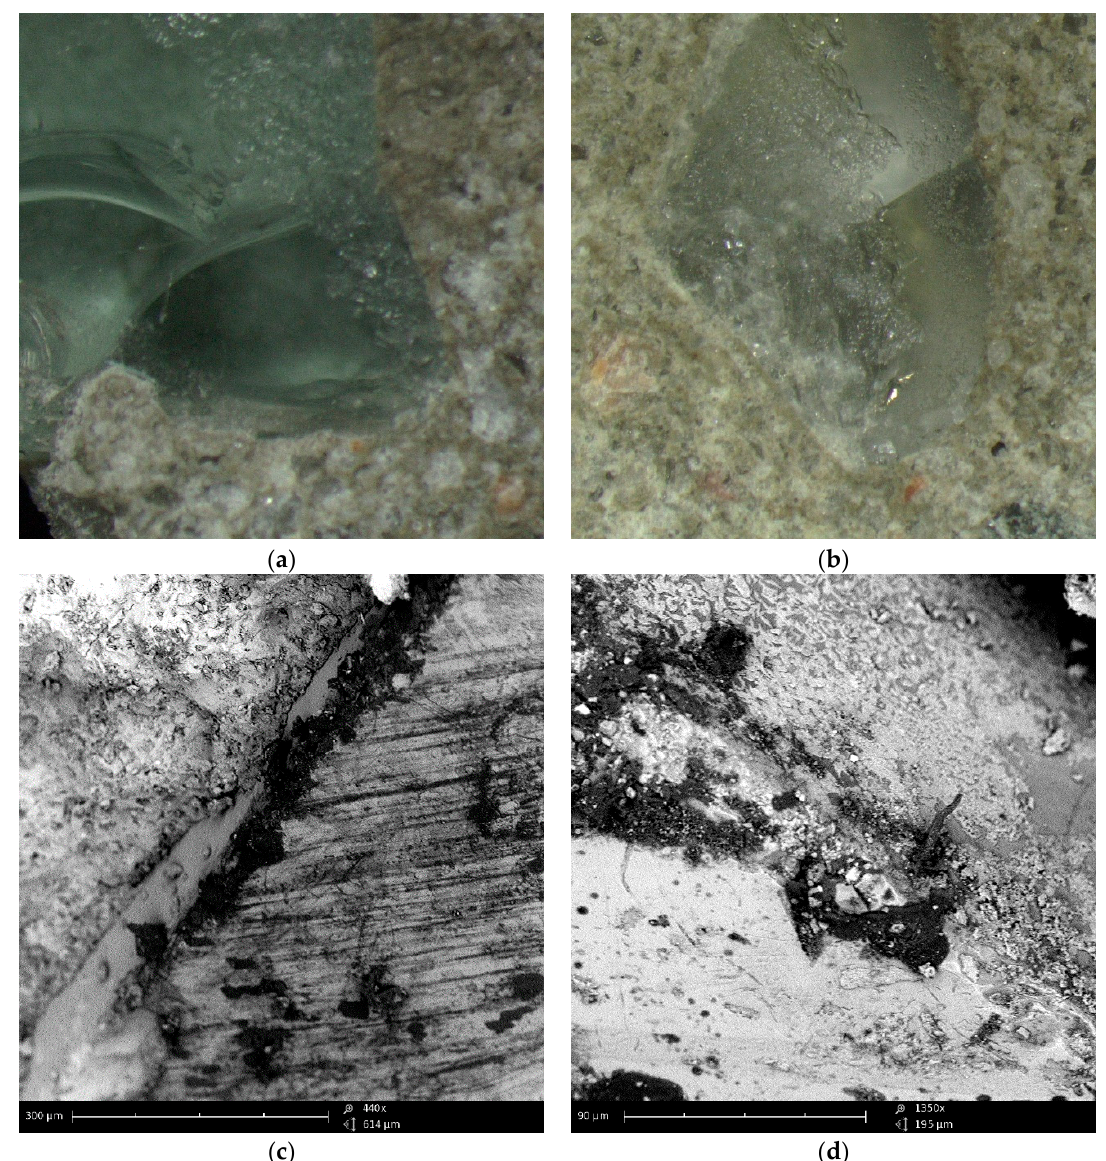
Figure 8. ITZ between the RGA grain and cement matrix: ( a , b ) under the optical microscope; ( c ) SEM image (magnification × 440); ( d ) SEM image (magnification × 1350). Analysis of the SEM photos indicates that the basalt and RGA grains have a very similar surface structure. Both types are broken aggregates. The grain surface is sharp and ragged. Basalt grains also have a glassy surface, and cohesion between the grains and cement paste is guaranteed by